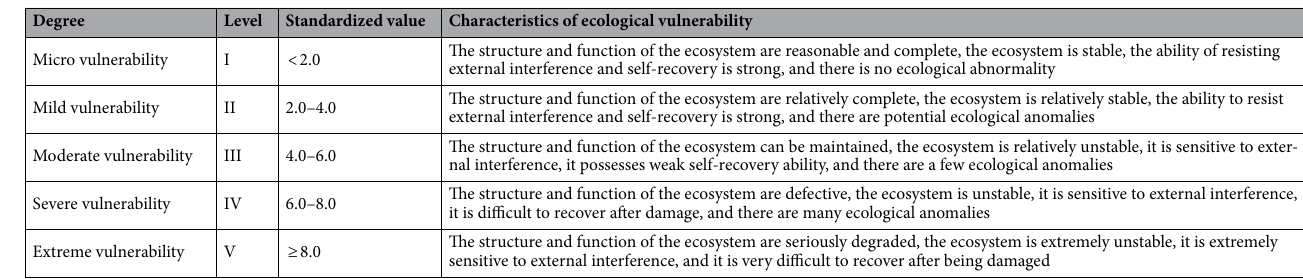
Table 4. Ecological vulnerability grading standard of